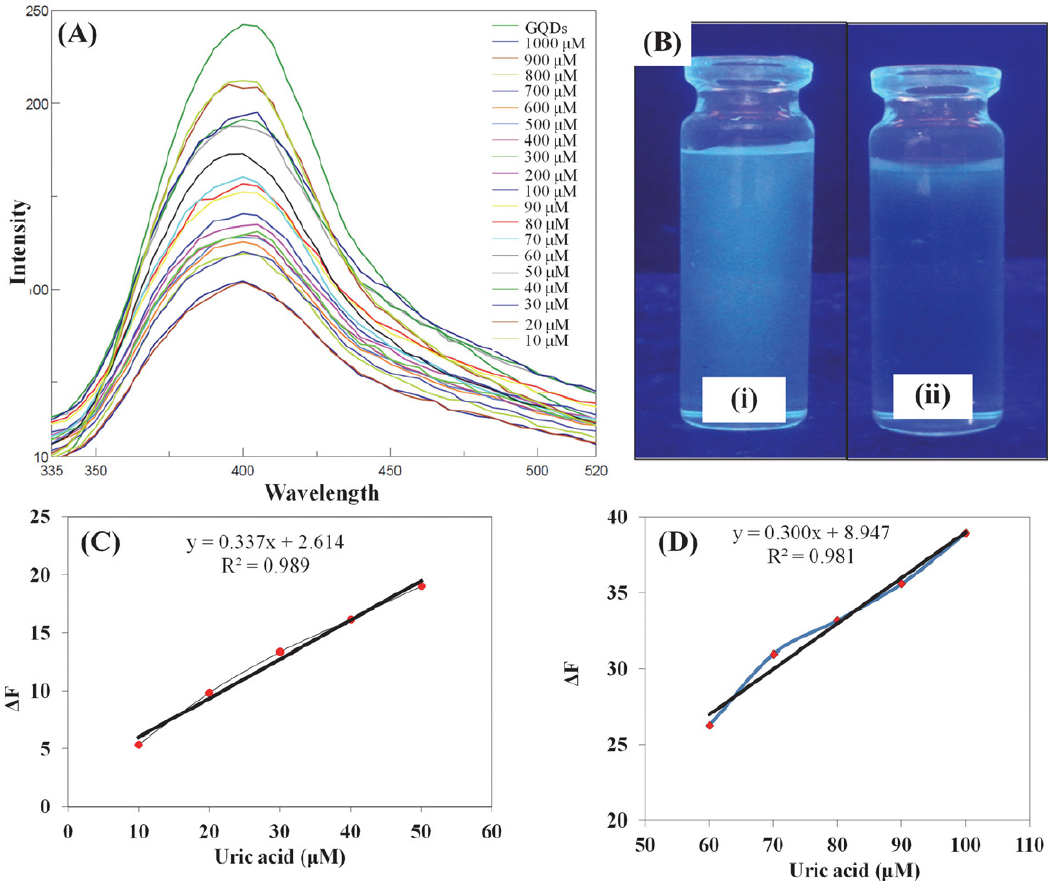
Figure 6: (A) Fluorescence spectra of N-GQDs with different concentrations of UA; (B) Fluorescence of N-GQDs before (i) and after addition of UA (ii); Fluorescence quenching linearity curve [ΔF vs UA concentration ranging from 10 μM to 50 μM (C) and (D) 60 μM to 100 μM, n =